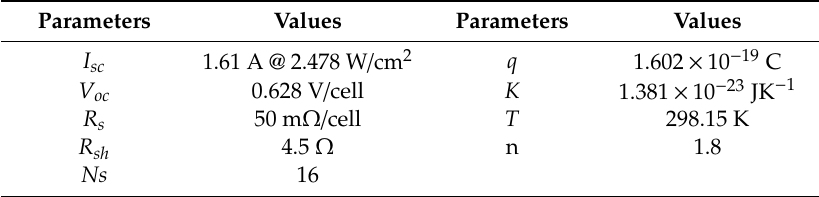
Table 1. Parameters of laser PV module in simulation